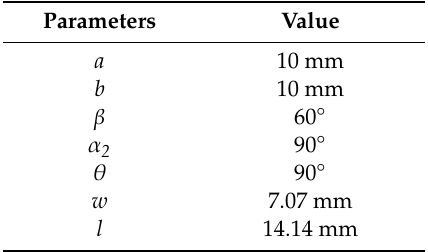
Table 1. The Parameters of the Pneumatic Foldable Actuator.